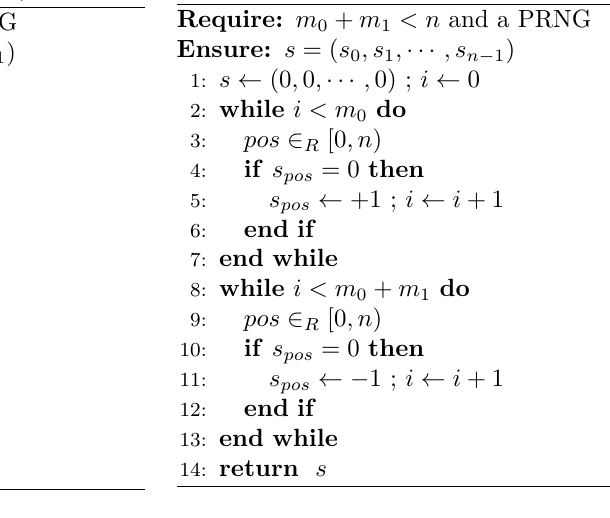
Algorithm 9 Trinary Sampling with m non- zero coefficients (+1’s and − 1’s)